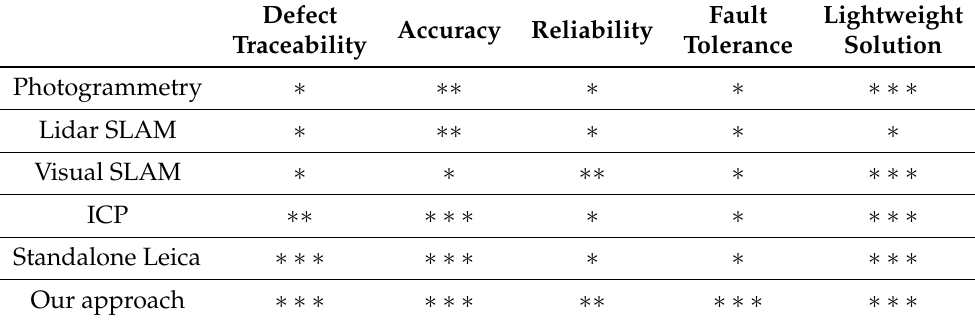
Table 1. Related work on localization systems for inspection applications. We indicate if defect trace- ability is enabled by a time-persistent reference frame, accuracy is enough, reliability is guaranteed by a constant stream at high frequency, the system is tolerant to failures, and it enables a lightweight solution. Where ∗ , ∗∗ and ∗ ∗ ∗ mean minimum, medium and maximun values